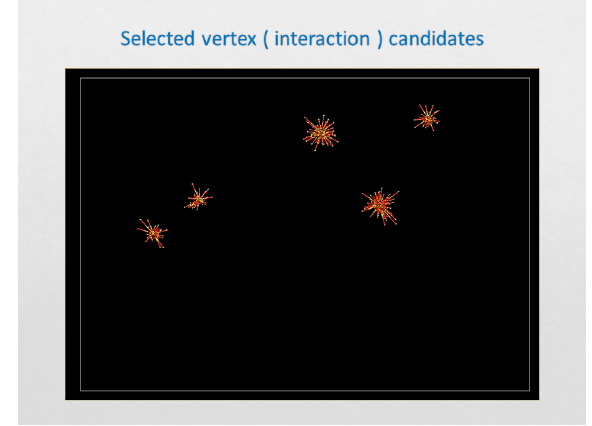
Fig 8. 3D display of selected vertices using linklets between plate #5 and #6 in zone = 5 (13cm into the emulsion